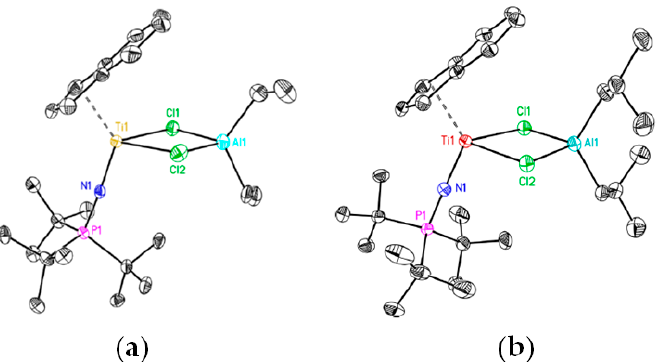
Figure 5. Molecular structure of Ti–Al complexes ( a ) Ti-13 and ( b ) Ti-15 . Reprinted with permission from [88]. Copyright (2021) American Chemical Society.